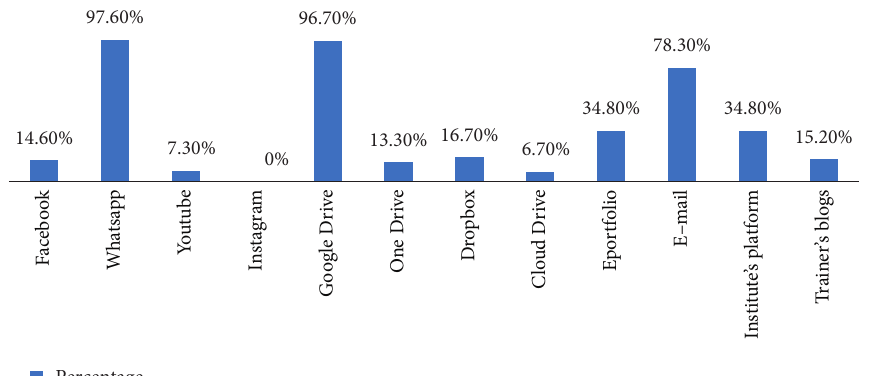
Figure 4: The digital tools used by prospective teachers during discussions with trainers.